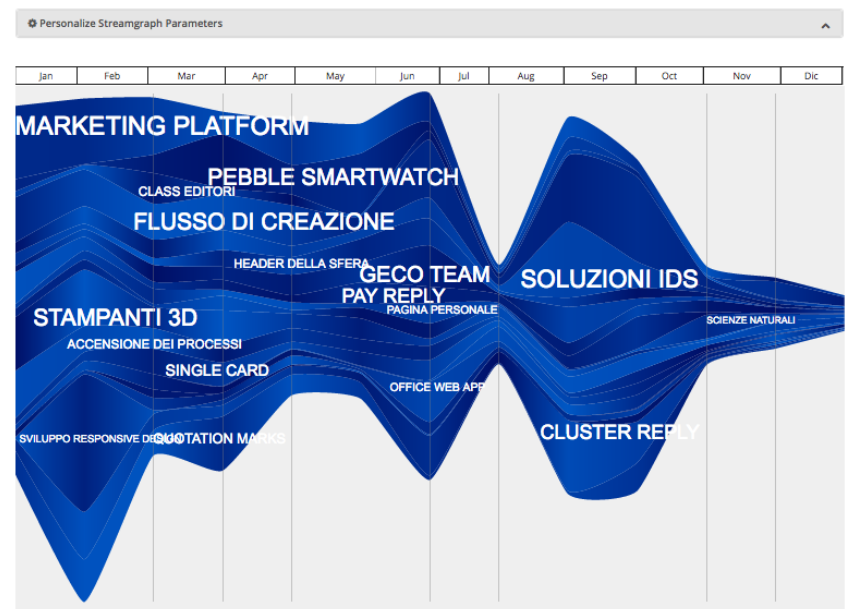
Figure 6. Stream graph of the main discussed topics during